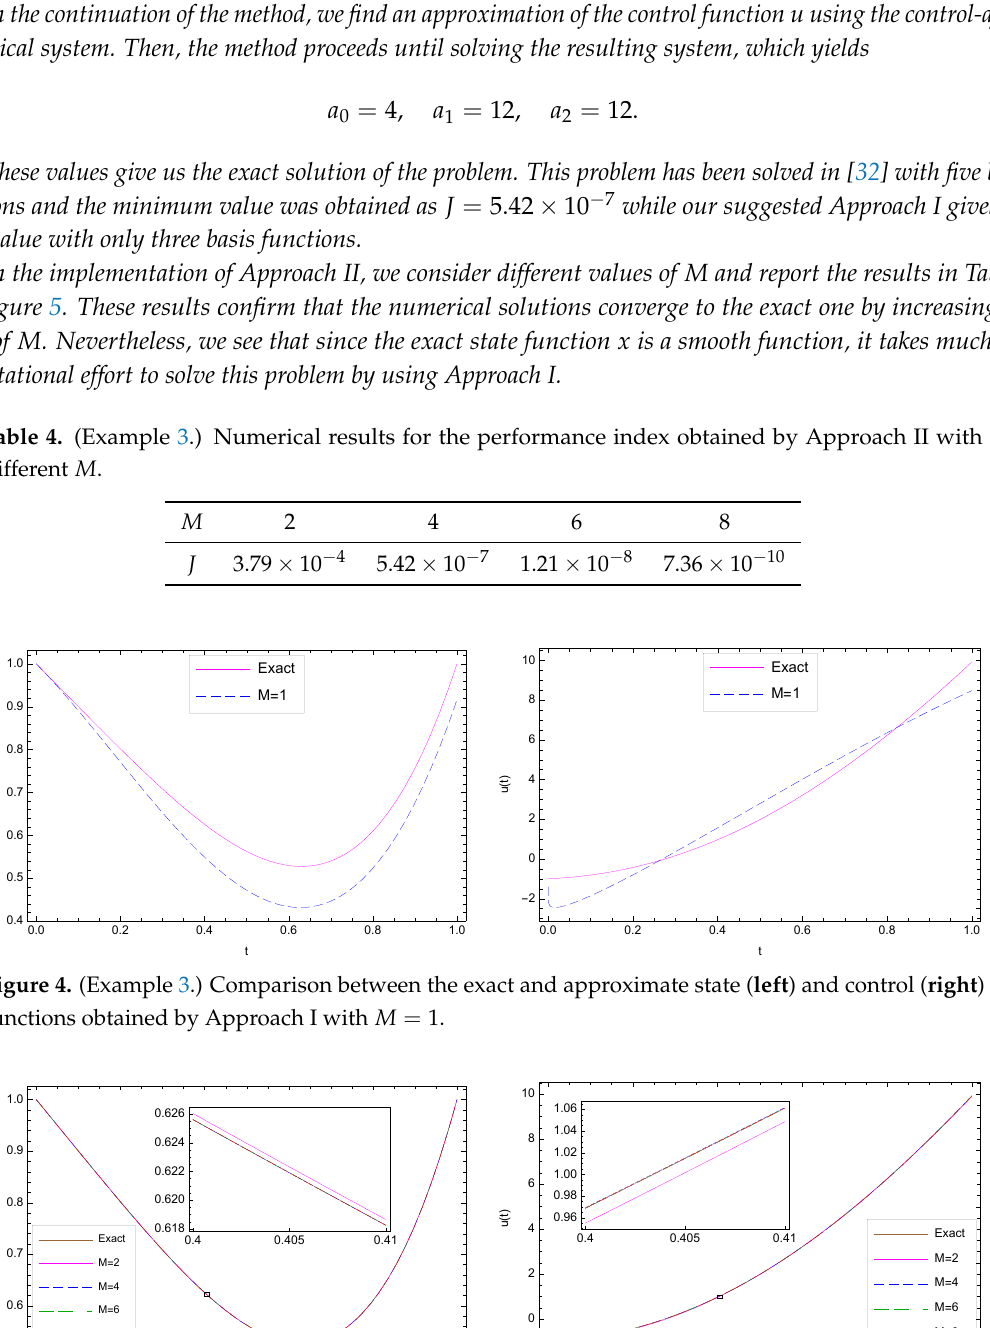
Figure 5. (Example 3.) Comparison between the exact and approximate state ( left ) and control ( right ) functions obtained by Approach II with different values of M